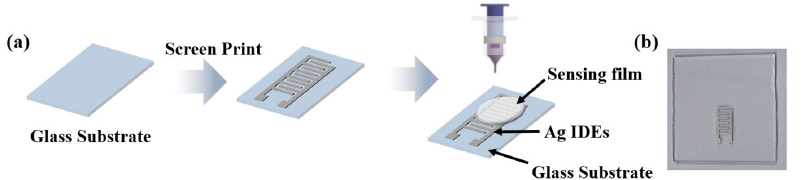
Figure 1. ( a ) Fabrication schematic of cellulose-based humidity sensors. ( b ) The photo of CIL@Cl ‐ 2 sensor.